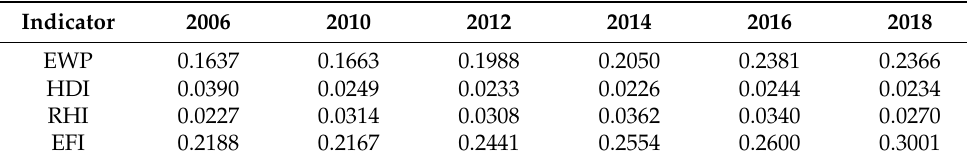
Table 5. Dagum Gini coefficient of EWP and its components in China.